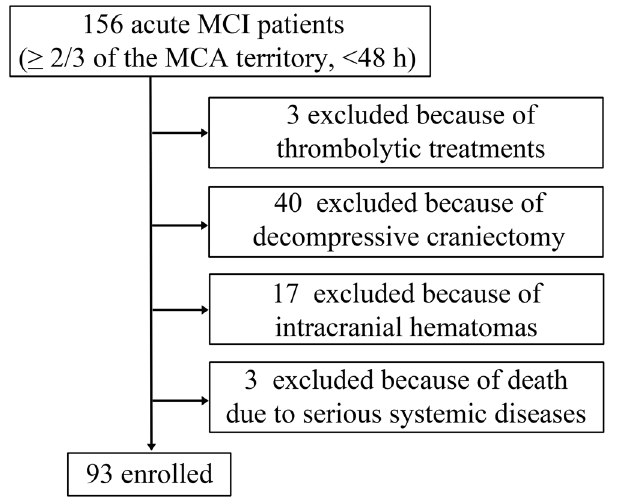
Figure 1. Patient enrollment flow